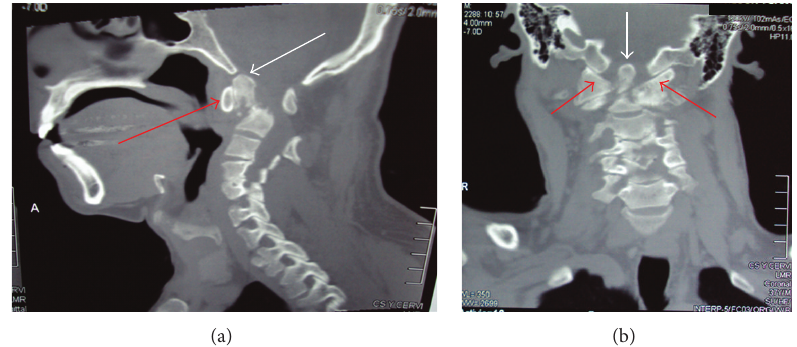
Figure 1: Initial CT of the cervical spine. (a) Sagittal image. Red arrow indicates the anterior arch of the C1 vertebrae (Atlas). The white arrow indicates the odontoid process fractured from the rest of the C2 vertebrae. (b) Coronal image of the initial CT. White arrow: odontoid process of C2 vertebrae with the fracture seen underneath it. Red arrow: lateral masses of the Atlas (C1 vertebrae).